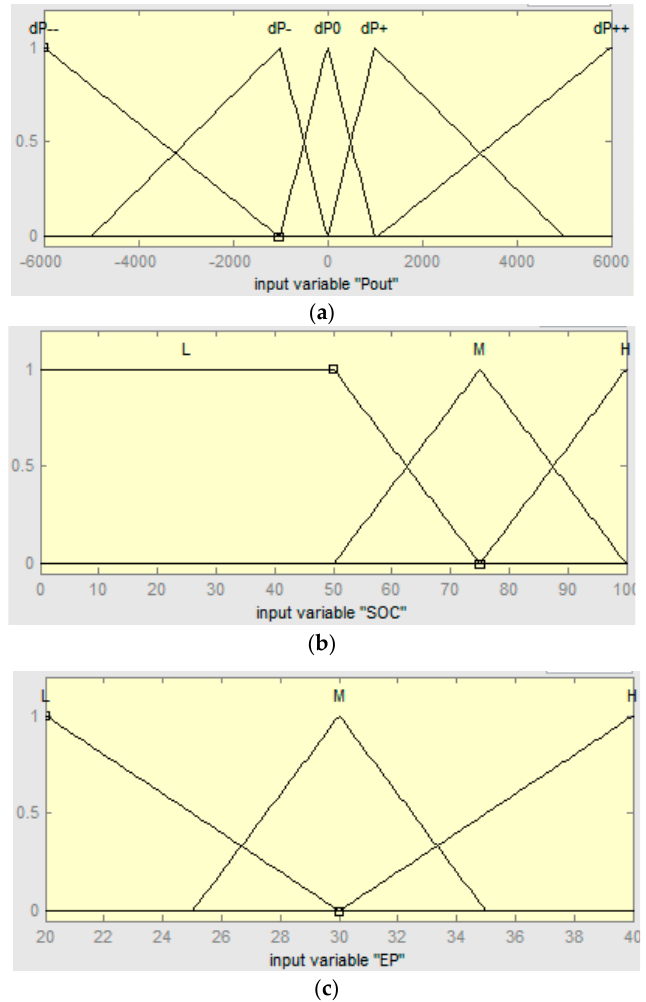
Figure 4. Membership functions of fuzzy controller inputs: ( a ) power difference Pout between PV supply and load (W), ( b ) ESS SOC level (%), and ( c ) electricity price EP (€/MWh).